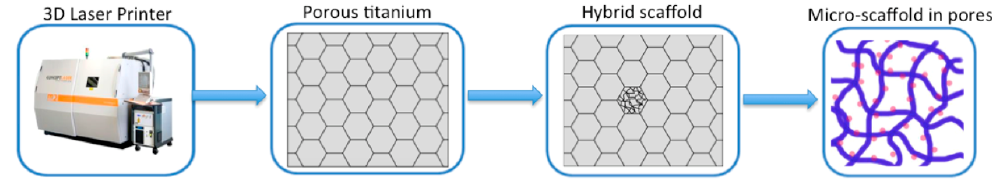
Figure 1. Schematic of the fabrication process of hybrid scaffolds.